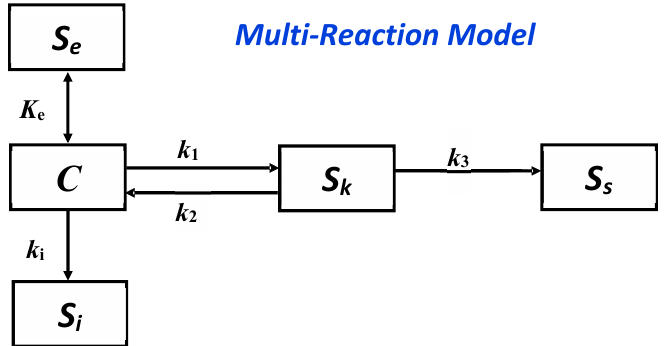
Figure 1. A schematic diagram of the multi-reaction model (MRM).